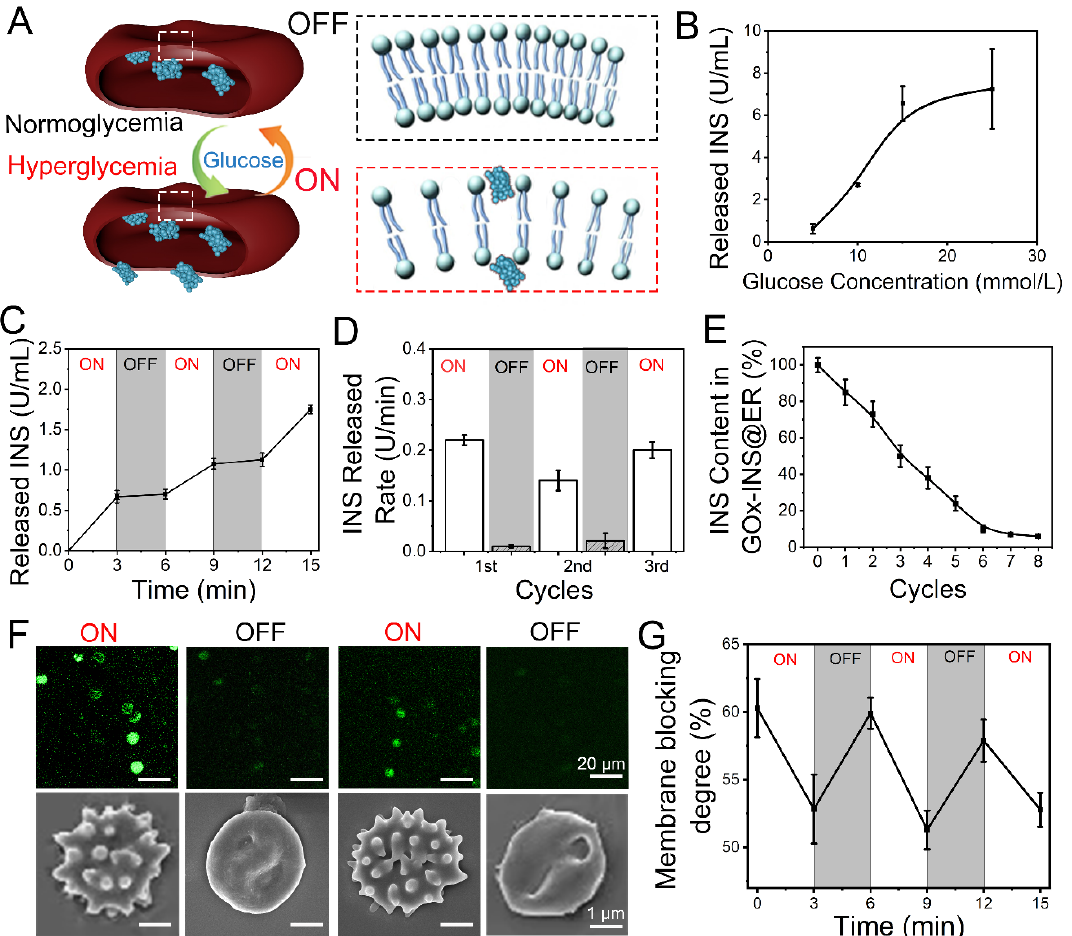
Figure 4. Glucose-responsive release behavior of GOx-INS@ERs (constructed via the CAER platform) in vitro. ( A ) Schematic diagram of a GOx-INS@ER’s blood glucose-responsive INS release. Under hyperglycemic conditions, INS is released from a GOx-INS@ER as the pore of the bilayer lipid membrane opens, indicating the “on” status of the GOx-INS@ER. When the blood glucose level returns to normal, the GOx-INS@ER stops INS release and maintains its spherical shape with the integrated cellular membrane (“off”). ( B ) INS release behavior of GOx-INS@ERs in different concentrations of glucose at 37 °C. ( C ) Glucose-responsive INS release behavior of GOx-INS@ERs in different glucose levels (normoglycemia, 5 mmol/L; hyperglycemia, 15 mmol/L) at 37 °C. ( D ) INS release rate of GOx-INS@ERs in “on-off” cycles at 37 °C. ( E ) The change curve of INS in GOx-INS@ERs during the INS release cycle tests. ( F ) Generation and quenching of ROS and SEM images representing the morphological changes of GOx-INS@ERs in the “on” or “off” state. ( G ) GOx-INS@ER membrane blocking degree curve during “on-off” cycles (normoglycemia, OFF; hyperglycemia, ON).